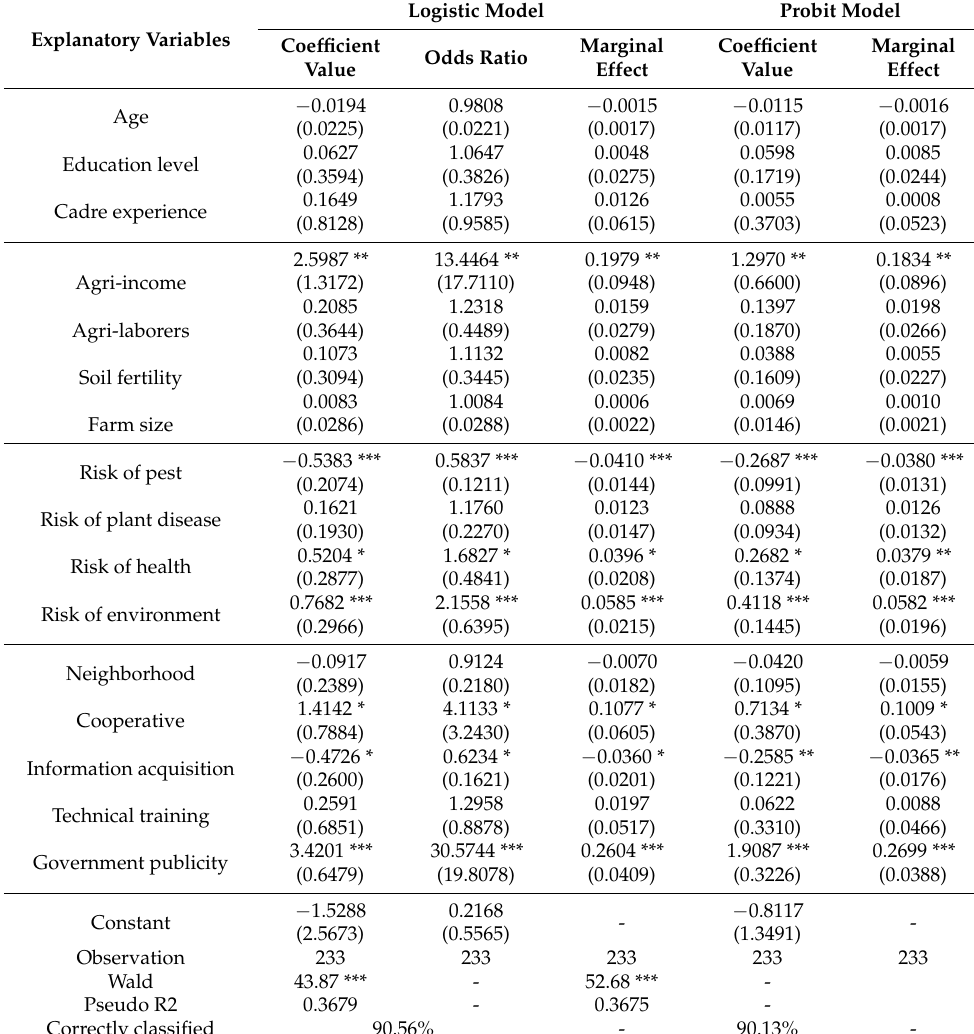
Table 4. Estimation of the CPD acceptance